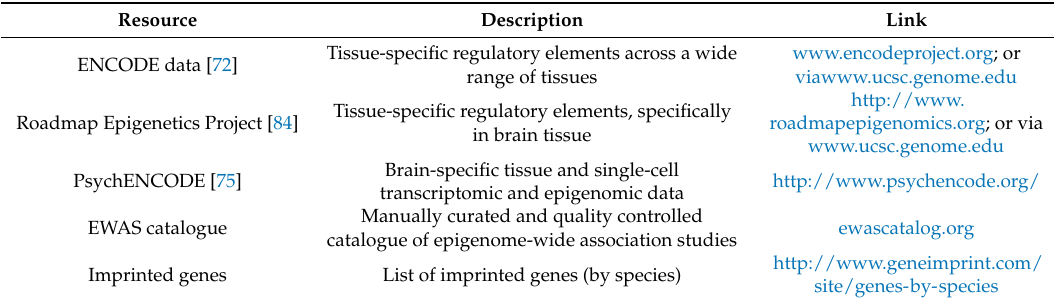
Table 5. Selection of resources to aid in the biological characterisation of DNA methylation